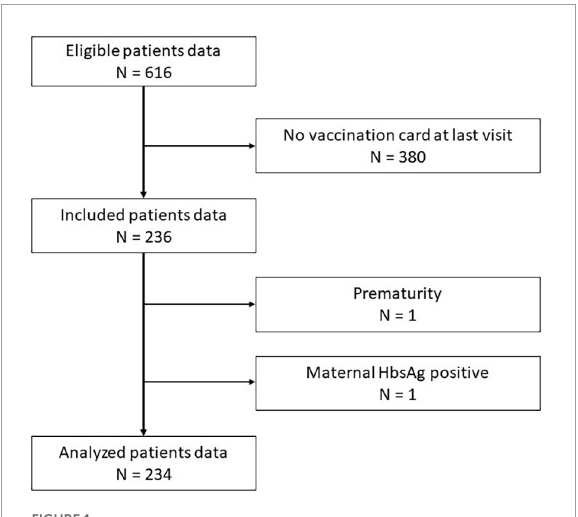
FIGURE1 Flow chart study cohort. HbsAg, Hepatitis B antigen.